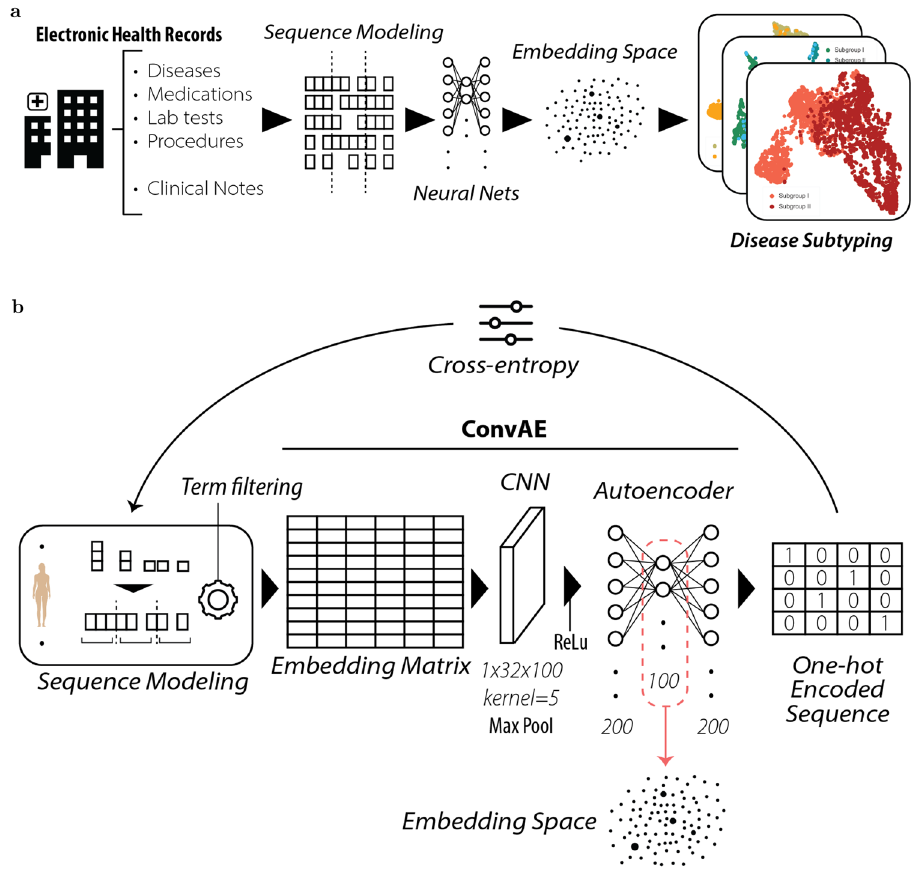
Fig. 1 Patient strati fi cation framework and ConvAE architecture. a Framework enabling patient strati fi cation analysis from deep unsupervised EHR representations; b Details of the ConvAE representation learning